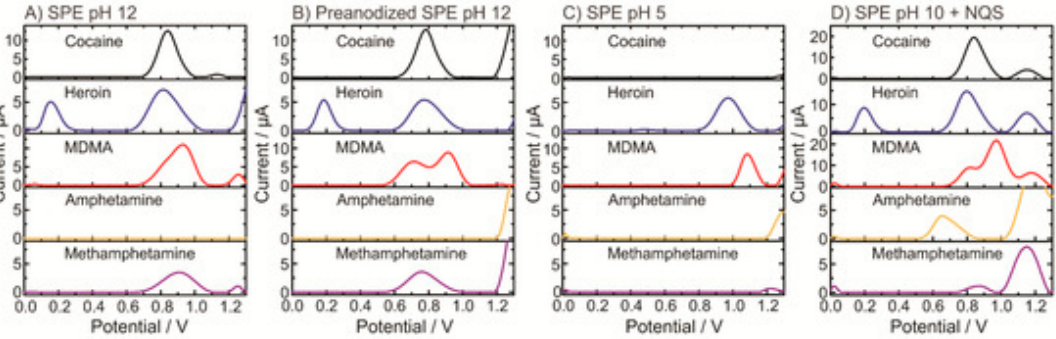
Figure 2. Electrochemical profiles of four illicit drugs acquired by SWV using unmodified carbon SPEs at different pHs and conditions [46]. Reused from MDPI under a Creative Common CC BY